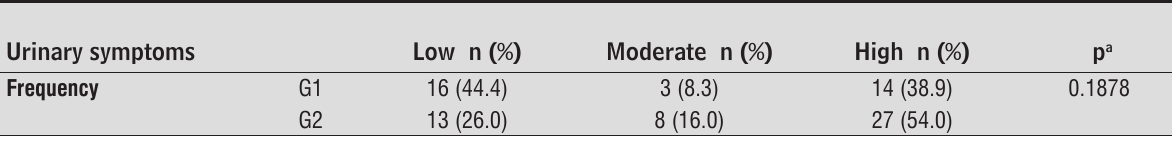
Table 3 - Urinary symptoms scale by King’s Health Questionnaire (KHQ) in women on reproductive age (G1) and on post- menopausal period